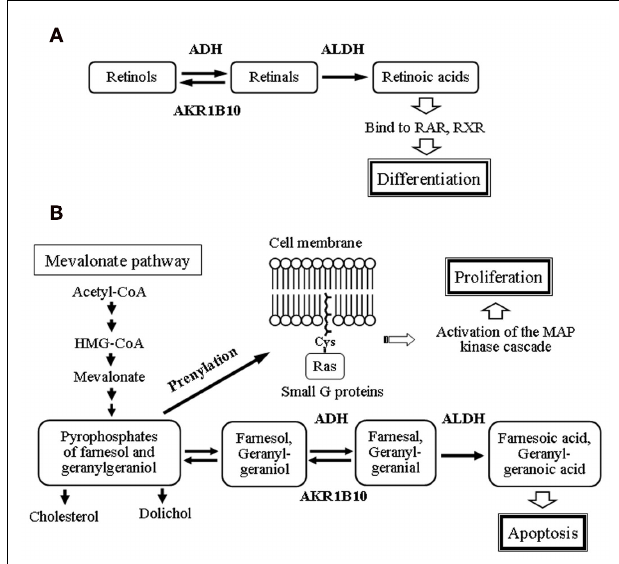
FIGURE 1 | Metabolism of retinoids (A) and isoprenoids (B). (A) all- trans -Retinol, 13- cis -retinol, and 9- cis -retinol are oxidized to the corresponding retinoic acids through retinals by alcohol dehydrogenases (ADH) and aldehyde dehydrogenases (ALDH). Retinoic acids regulate cell function including differentiation through binding to retinoic acid receptor (RAR) and retinoid X receptor (RXR). AKR1B10 effectively reduces retinals into retinols, and is considered to promote cell proliferation by inhibiting the retinoic acid formation. (B) Farnesyl pyrophosphate, an isoprenoid intermediate of the mevalonate pathway, is converted by its dephosphorylation into farnesol, which is further oxidized into farnesal and farnesoic acid by ADH and ALDH. Geranylgeranyl pyrophosphate is similarly metabolized.The two isoprenyl pyrophosphates are used in the prenylation of small G-proteins such as Ras, leading to activation of MAP kinase cascade and resultant increase in proliferation potential of cells. AKR1B10 efficiently reduces farnesal and geranylgeranial to farnesol and geranylgeraniol, respectively, which are phosphorylated into the isoprenyl pyrophosphates. Up-regulation of AKR1B10 in carcinomas and chemoresistant cancer cells may increase the cellular levels of the two isoprenyl alcohols by reducing back their aldehyde metabolites, and then promote proliferation of the